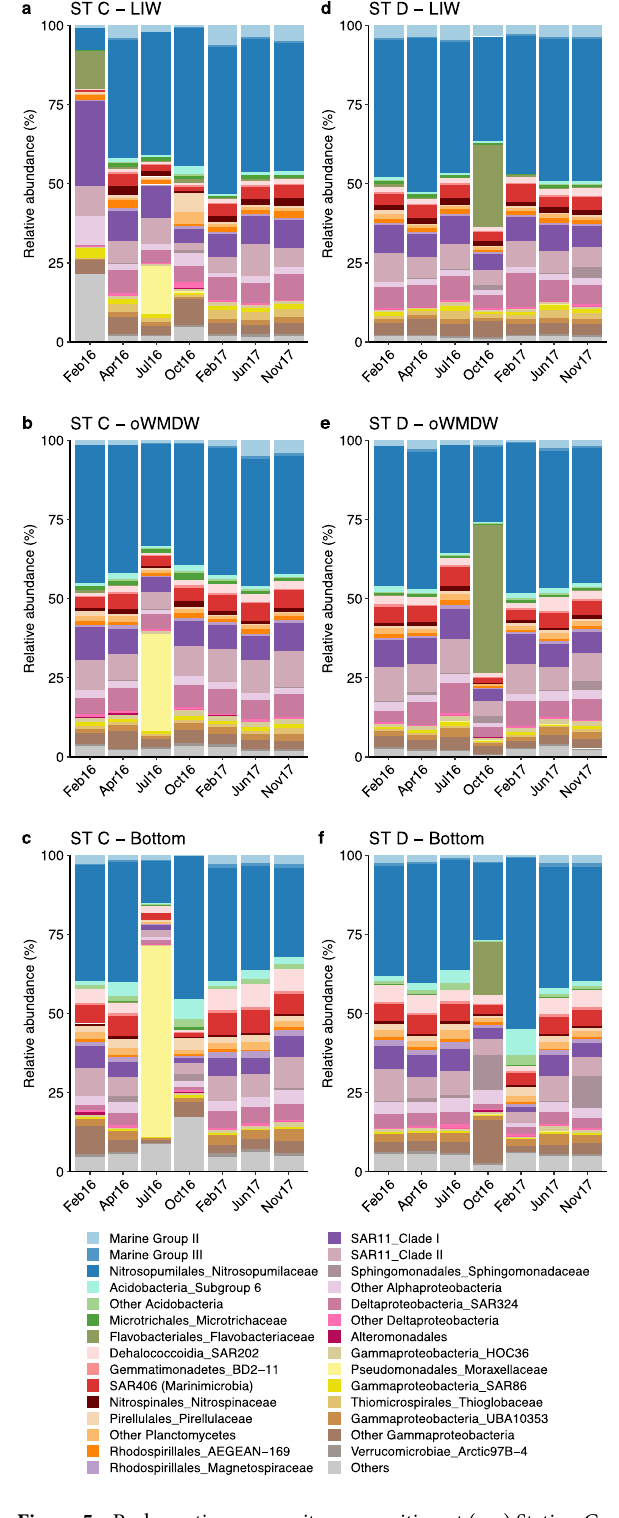
Figure 5. Prokaryotic community composition at ( a - c ) Station C and ( d - f ) Station D between February 2016 and November 2017. Stacked bar plots represent the relative abundance of phylotypes at the family level or maximum assigned level at ( a , d ) LIW: Levantine intermediate water, ( b , e ) oWMDW: old western Mediterranean deep water and ( c , f ) bottom water. Families or higher taxonomic groups that contribute ≤ 0.5% are combined in ‘Others’